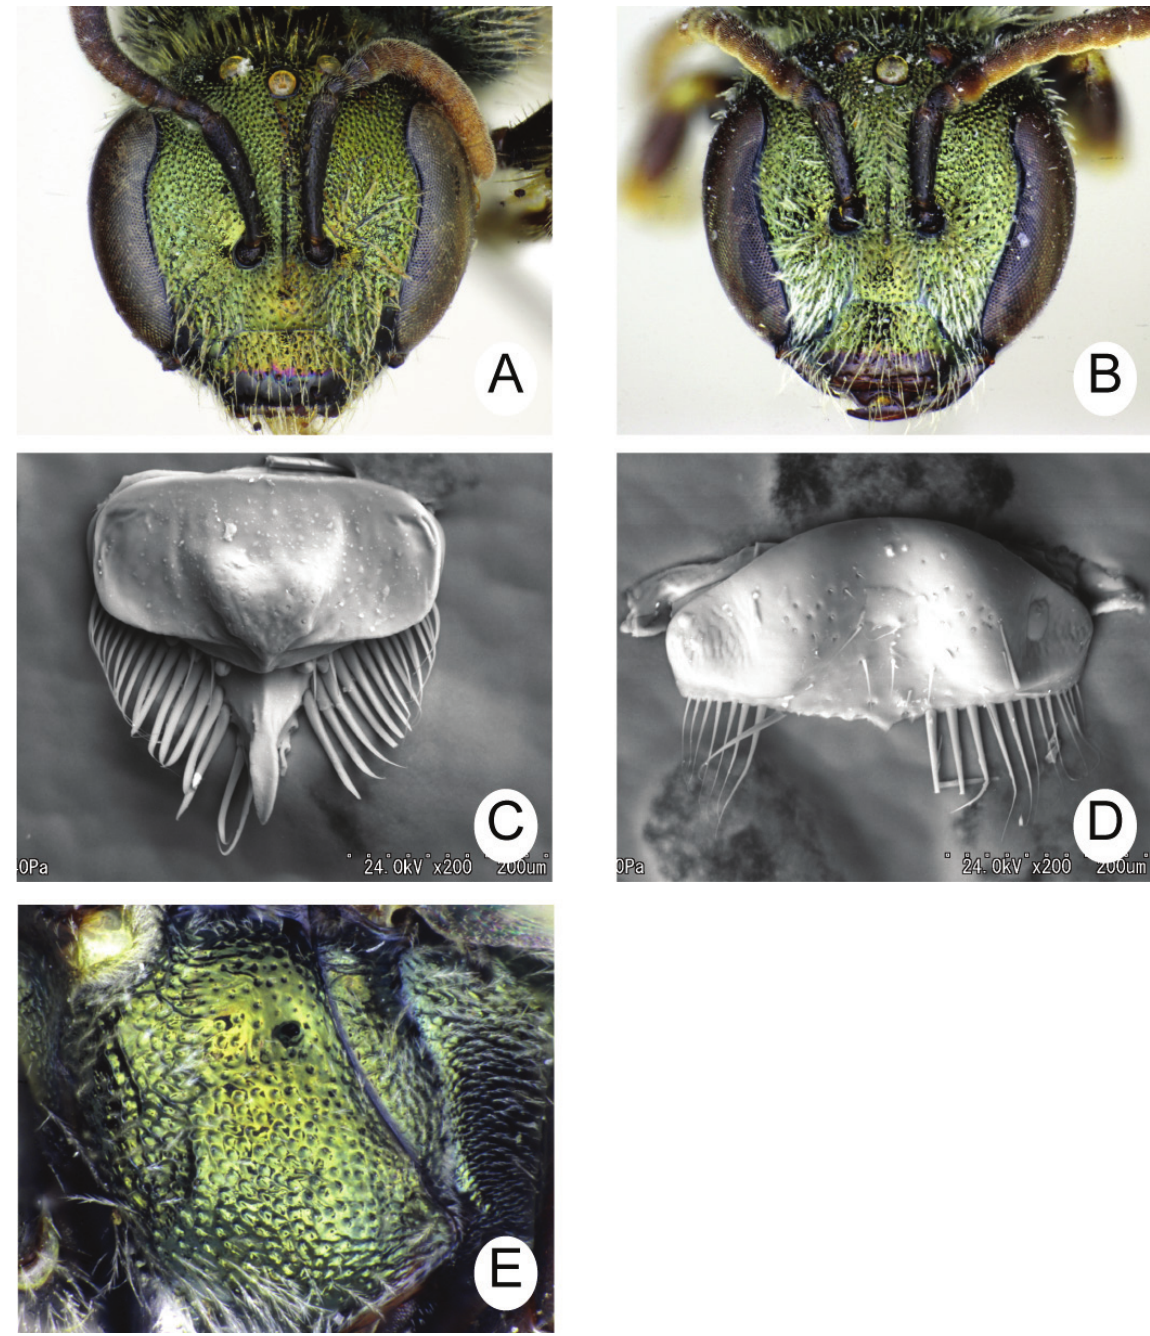
Fig. 1. A–E . Lasioglossum ( Dialictus ) viridellum (cockerell, 1931). A–B . head in frontal view. C–D . Labrum. E . Mesepisternum. A, C. ♀. B, D–E.